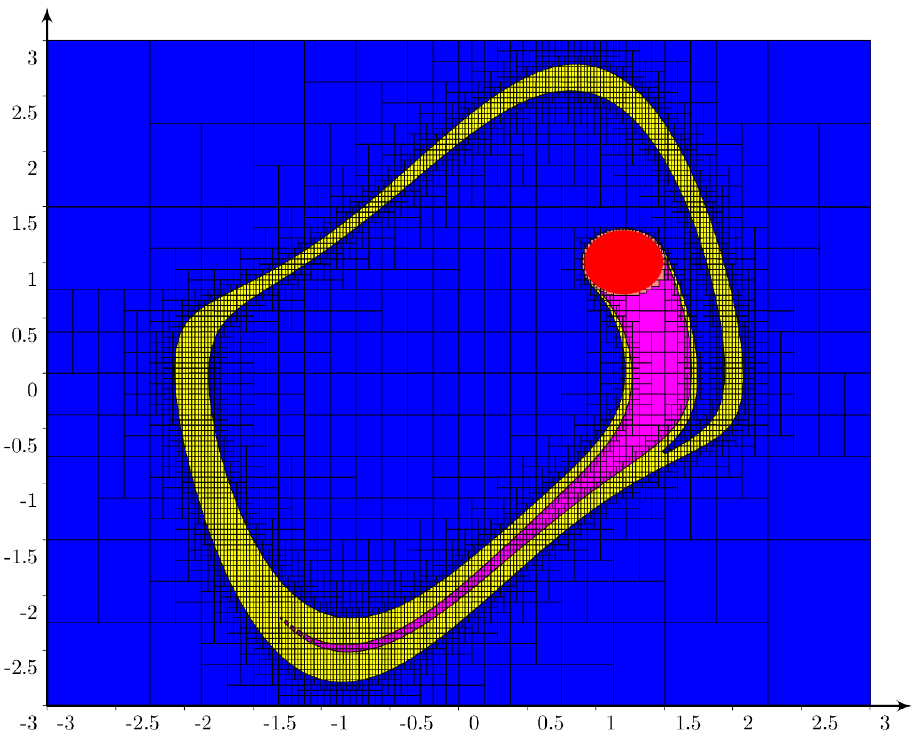
Figure 9. Forward reach set associated with the red disk A for an infinite time